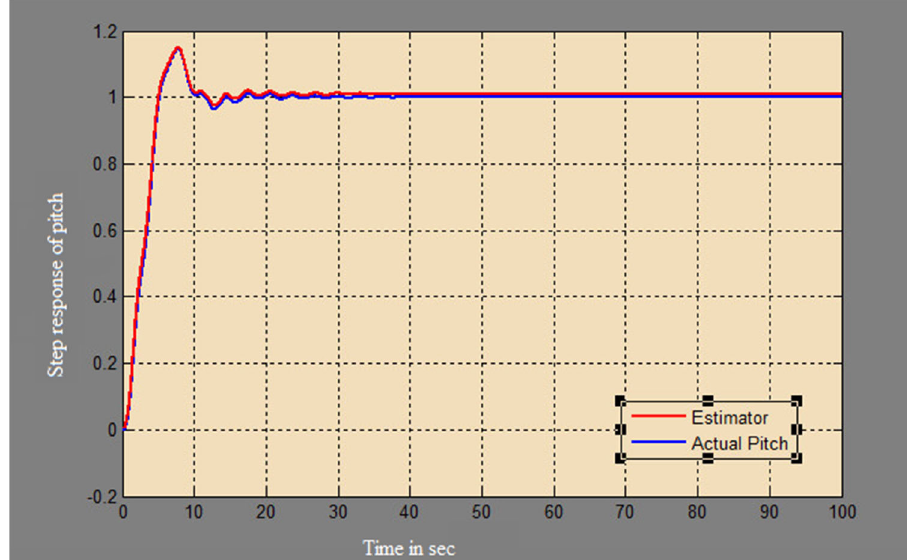
Figure 9. Estimation of a pitch for a step input with Luenberger